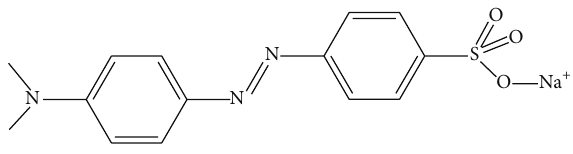
Figure 1: Chemical structure of methyl orange.